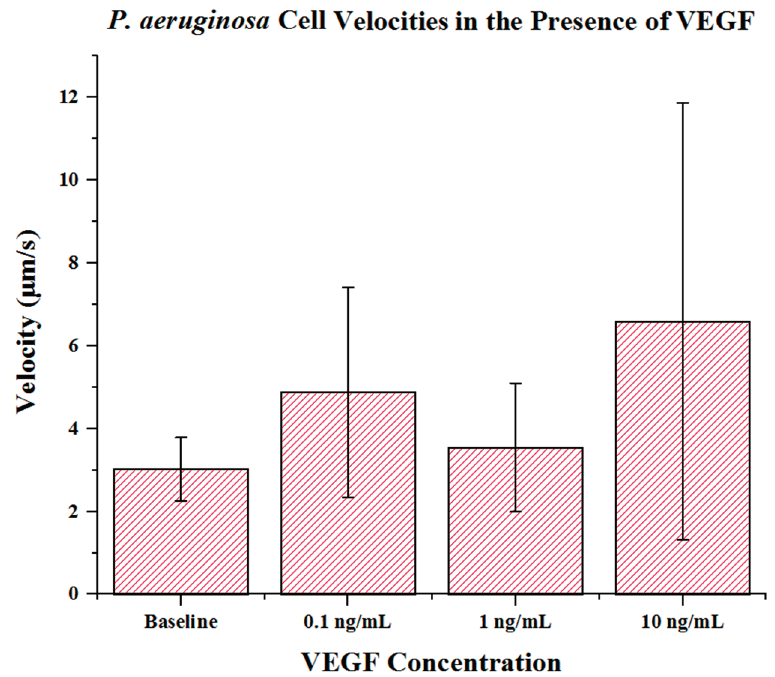
Figure 7. P. aeruginosa BK-76 cell velocities in VEGF concentration gradients. Results show that up until 10 ng/mL concentrations, P. aeruginosa cell velocities remain relatively similar. The highest cell speeds were seen in 10 ng/mL VEGF gradients, with the highest recorded cell speed being 26.63 μ m/s. Error bars show standard